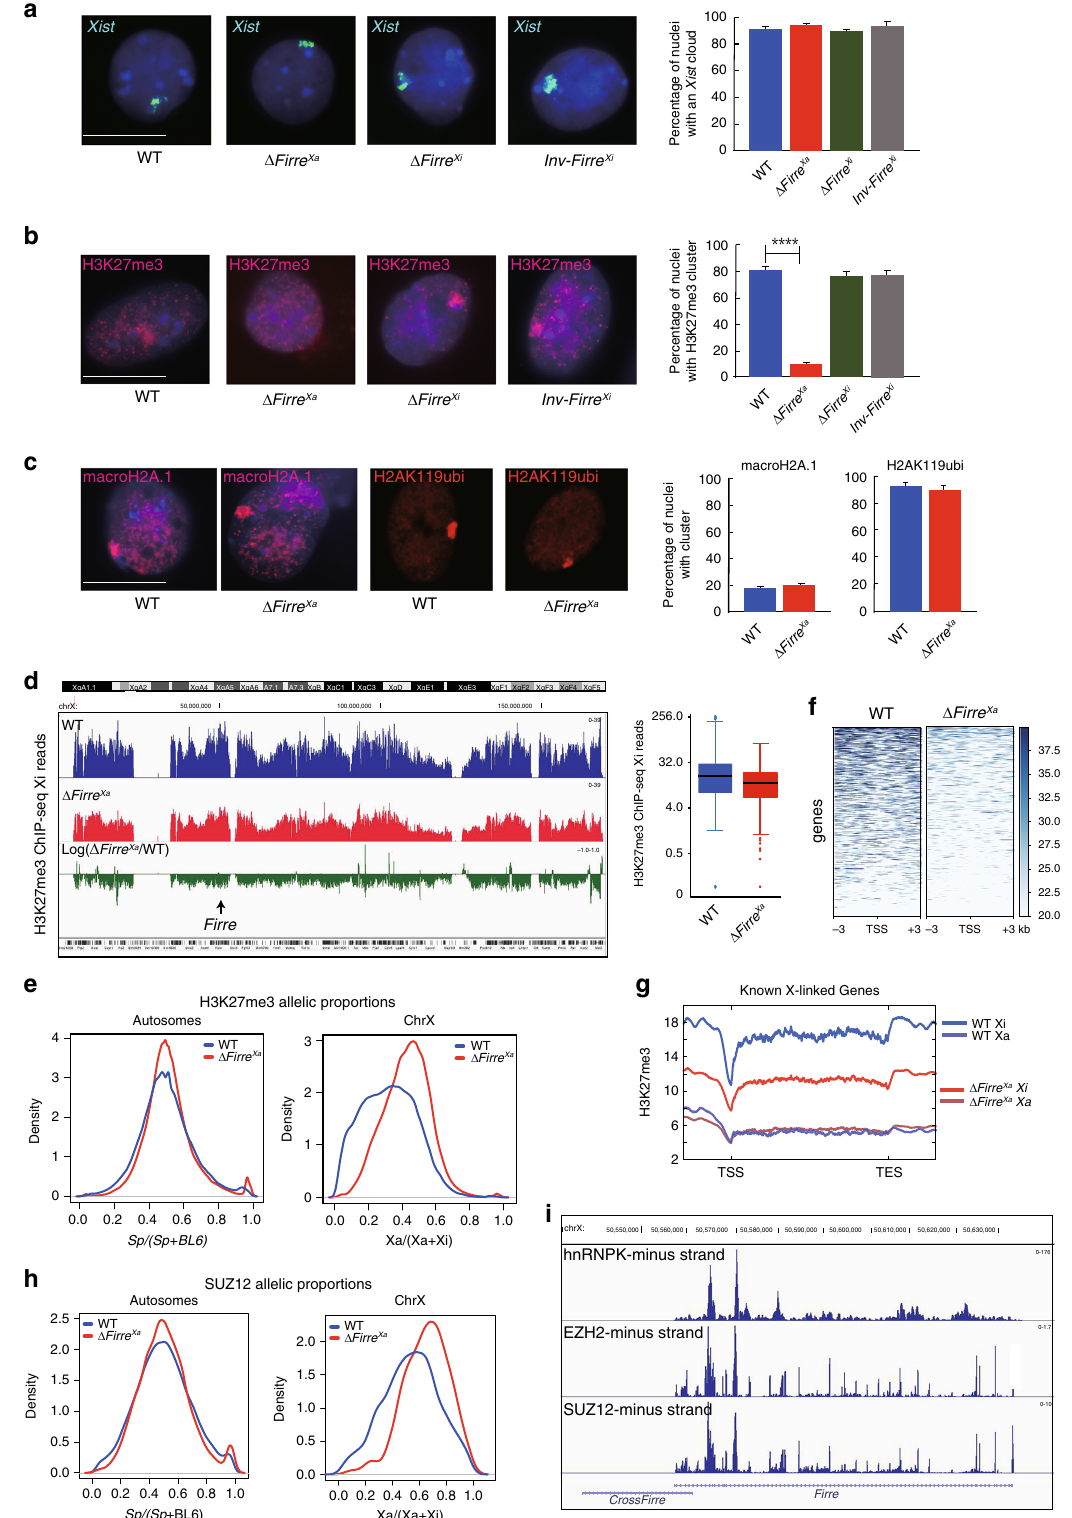
SUZ12, and with hnRNPK, a protein that recruits the non- canonical PCGF3/5-PRC1 (Fig. 2i; Supplementary Data 5) 39,40 . Analysis of data obtained by CLIP-seq and PAR-CLIP, two UV- crosslinking-based methods for highly accurate mapping of RNA- protein interactions, con fi rmed Firre RNA interactions with EZH2 and detected interactions with JARID2 and RBFOX2,